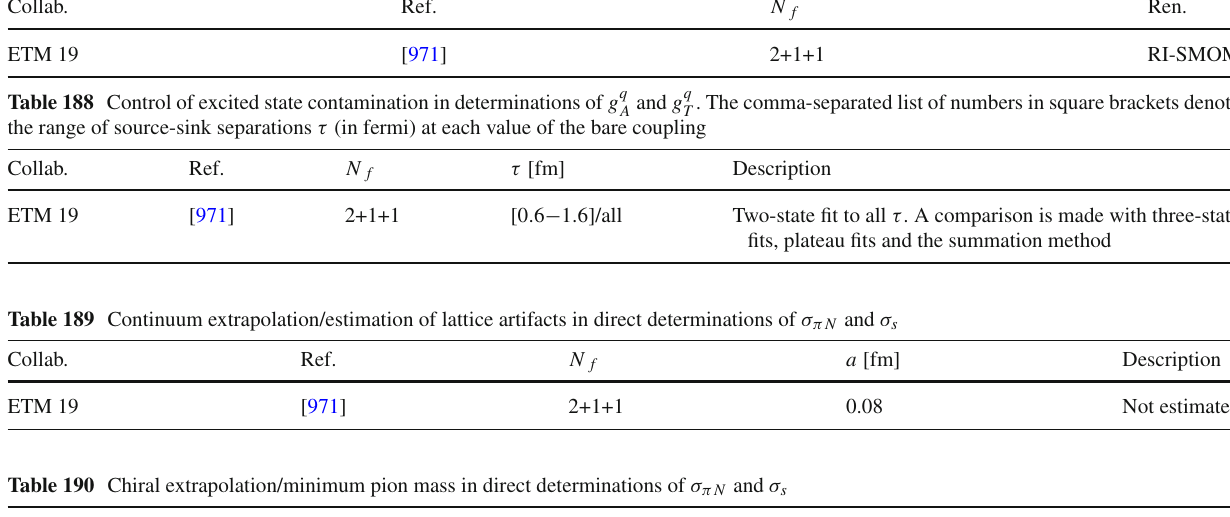
Table 187 Renormalization in determinations of g q Collab. Ref.